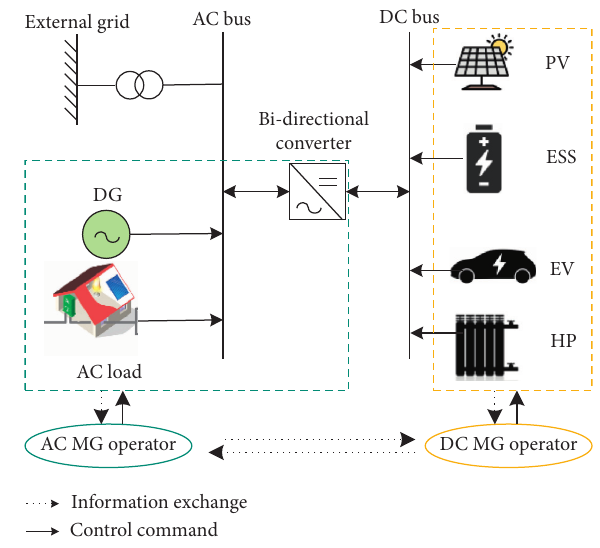
Figure 1: Physical and communication architecture of the hybrid AC/DC